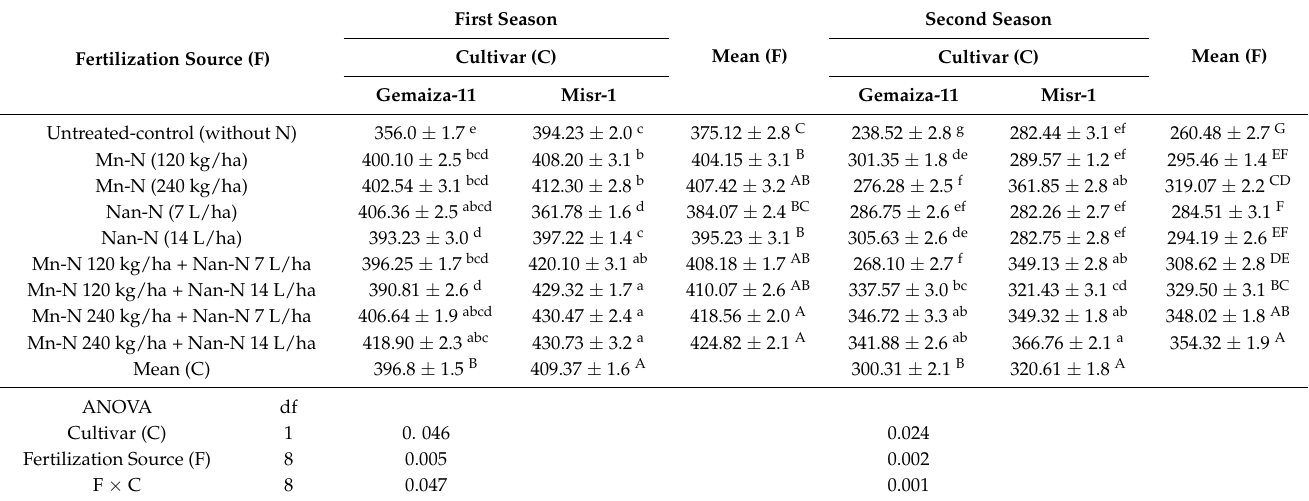
Table 3. Impact of nano- and mineral nitrogen fertilizers on number of tillers per square meter of two wheat cultivars during the 2019/2020 and 2020/2021